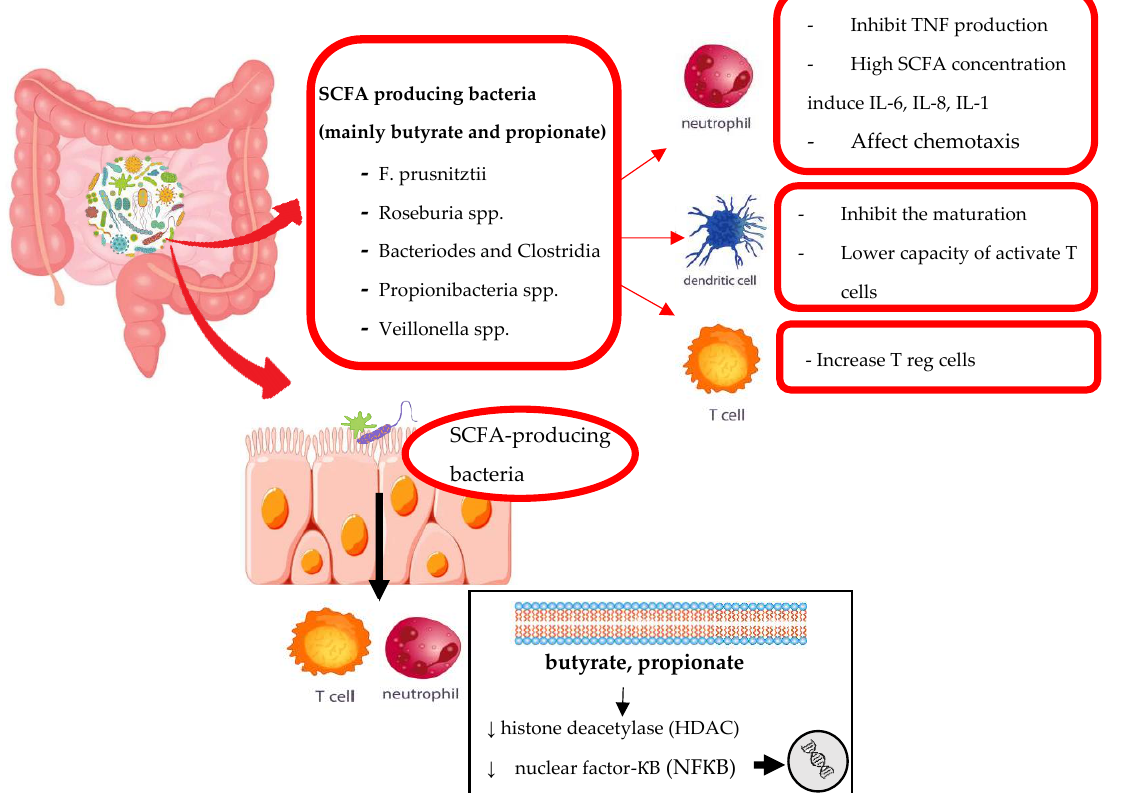
Figure 1. SCFA-producing bacteria generate butyrate, propionate and acetate in the gut. These compounds are able to inhibit histone deacetylase and nuclear factor- κ B provoking a modification in gene expression. Through this mechanism, SCFAs promote T reg cells differentiation, downregulate Th17 activity and induce the production of anti-inflammatory cytokines such as IL-10. On the other hand, very high concentration of SCFAs may induce the production of IL-1, IL-6 and IL-8. An imbalance in SCFA-producing bacteria might be the cause of inflammatory status.